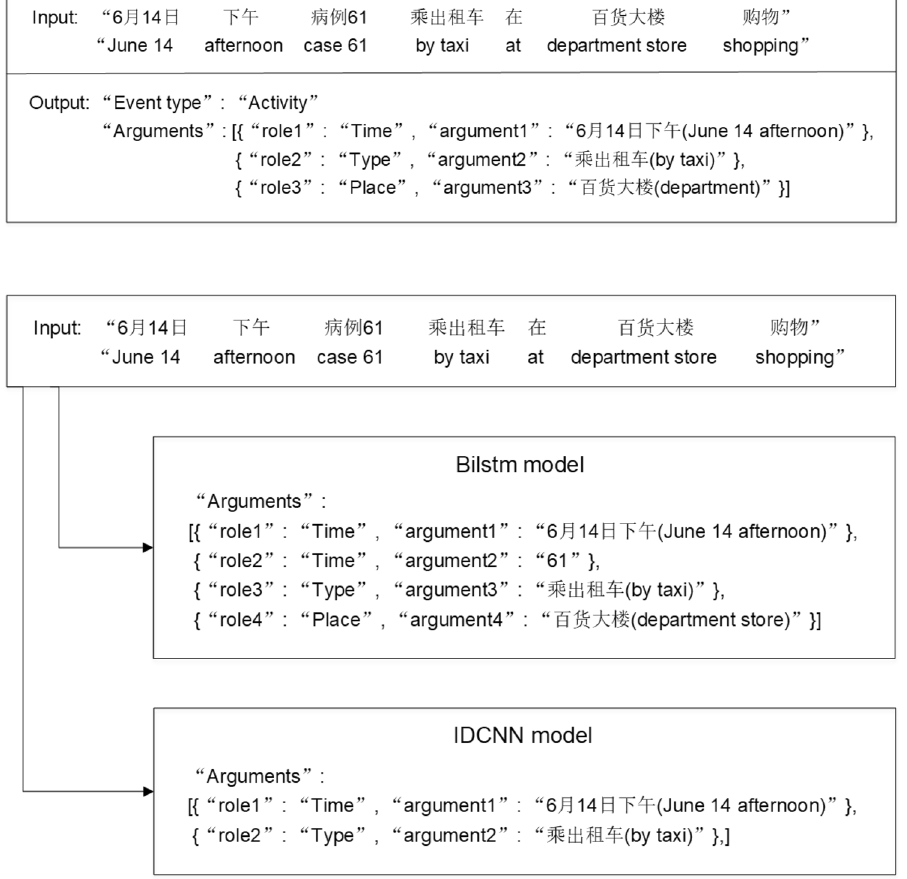
Fig. 1 Example of EE